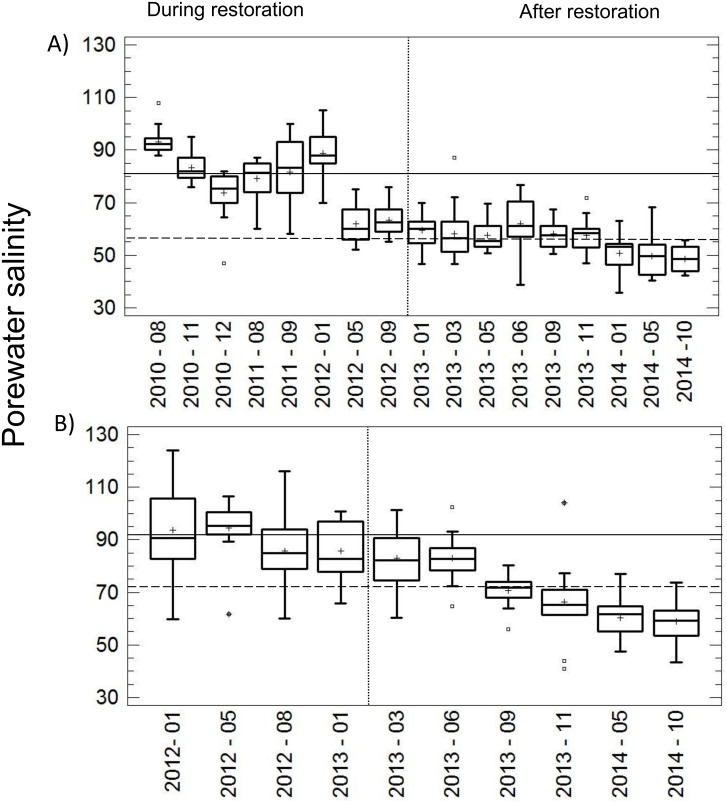
The behavior of porewater salinity during and after the restoration actions is shown.(A) Transect T1, located in Zone I where the restoration actions began in 2010 and ended in 2012 (this time-lapse considered as during the restoration actions); the years 2013–2014 were considered as after the restoration. (B) Transect T2 located in zone II: 2012 during restoration and 2013–2014 after restoration. The continuous and discontinuous lines represent the median values of the porewater salinity during and after the restoration actions, respectively. The boxes show the inter-quartile range, the thick black lines within the boxes are the medians, the cross represents the average, and the whiskers are the minimum and maximum values.